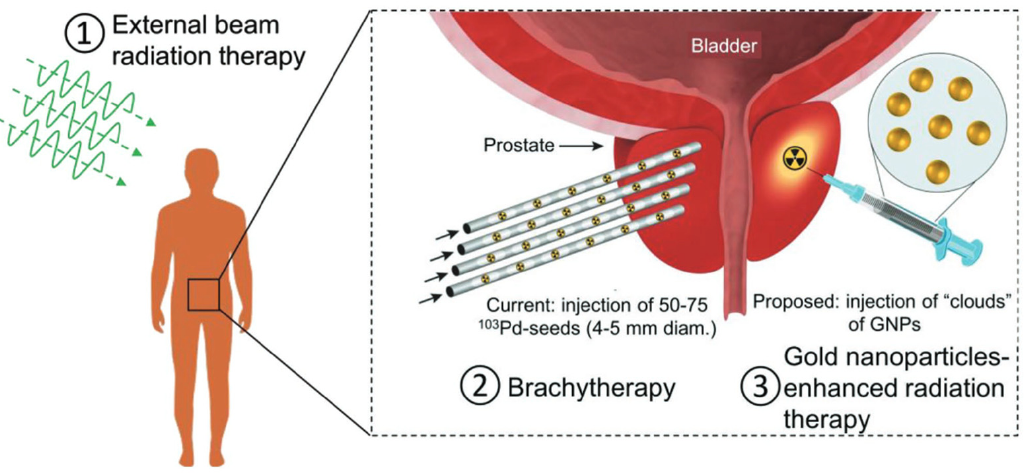
Figure 7. Three possible radiotherapy approaches: (1) External beam radiation therapy; (2) brachytherapy; (3) AuNPs-enhanced radiation therapy. Reprinted (adapted) with permission from [59], John Wiley and Sons .